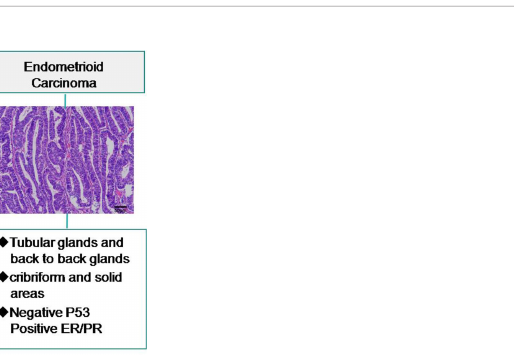
FIGURE 5 | Differential diagnosis of clear cell carcinoma of the endometrium and relevant